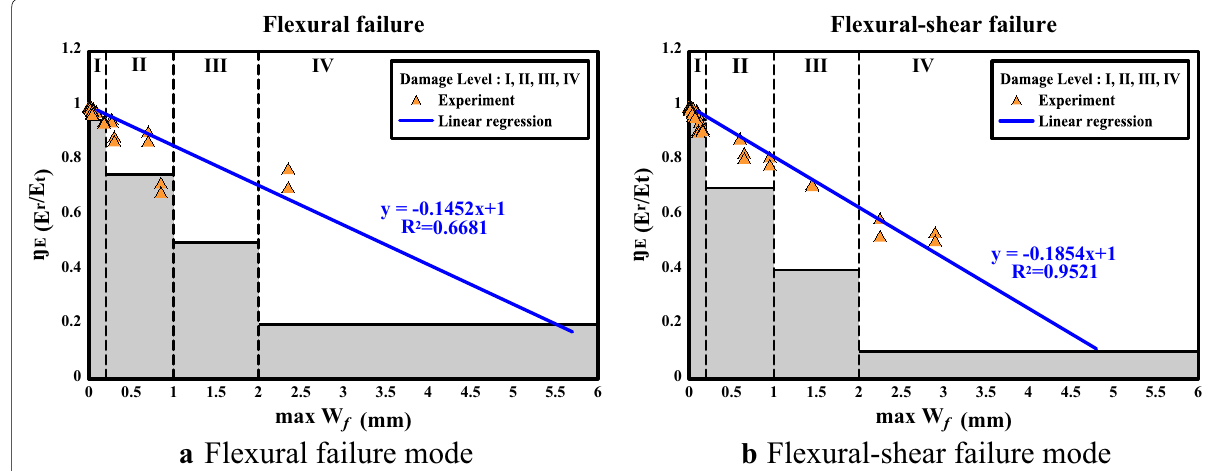
Fig. 14 Experimental reduction factors of energy dissipation capacity for the specimens with the flexural and flexural–shear failure modes.